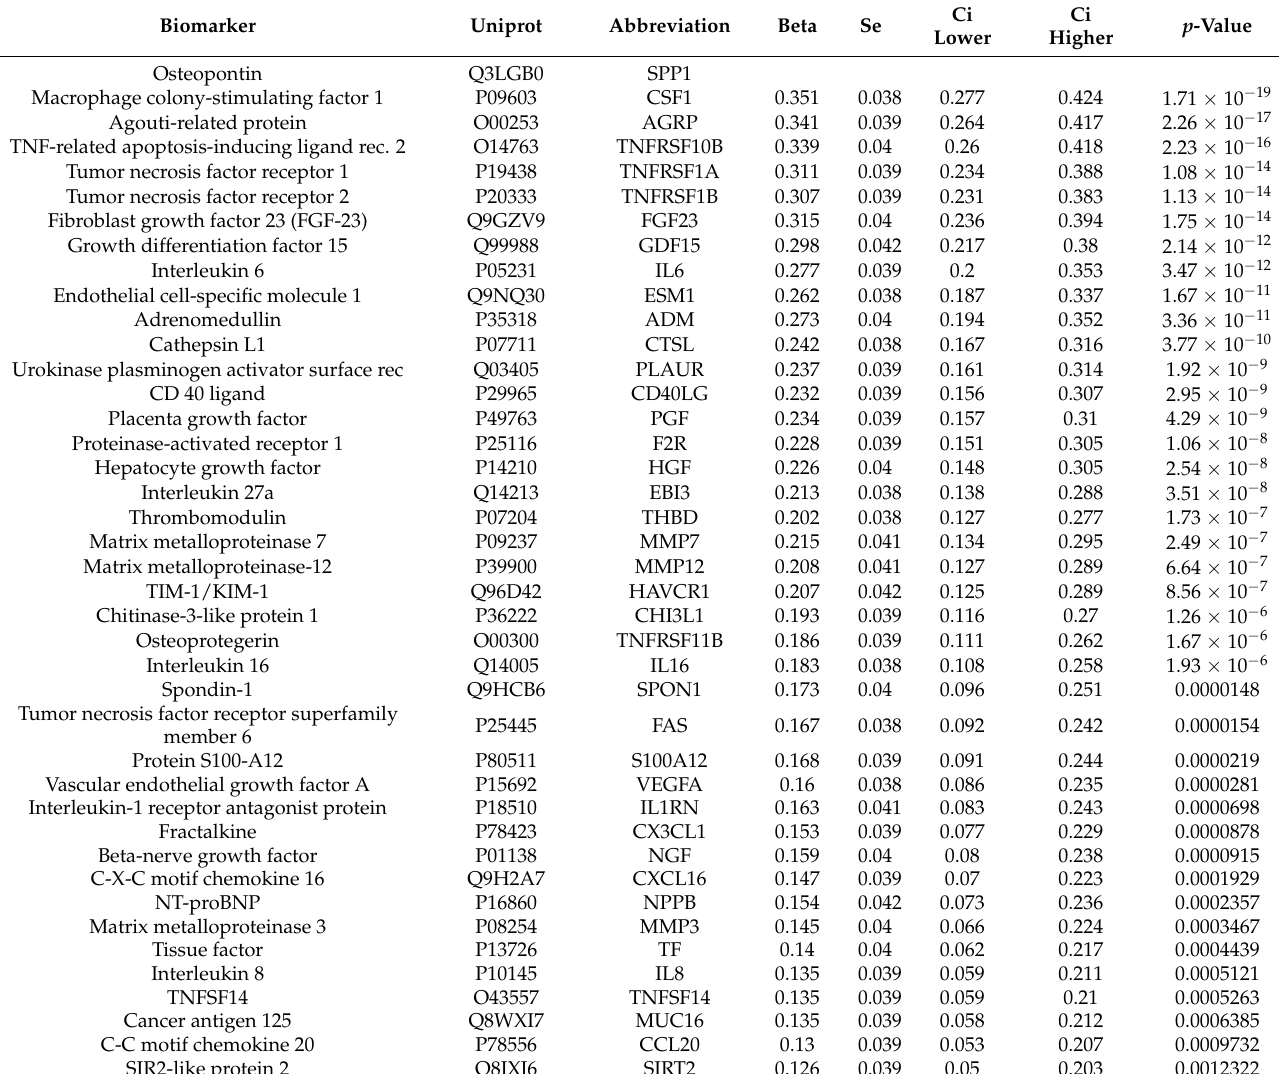
Table 3. Relationship between plasma osteopontin and each of the 40 cytokines that were most strongly associated with osteopontin in model B. Significant p -values after Bonferroni adjustment ( p = 5.88 × 10 − 4 ) are highlighted in grey. All proteins were ln-transformed, and then transformed to a SD scale. n = 652. Table sorted by p -value. ci = confidence